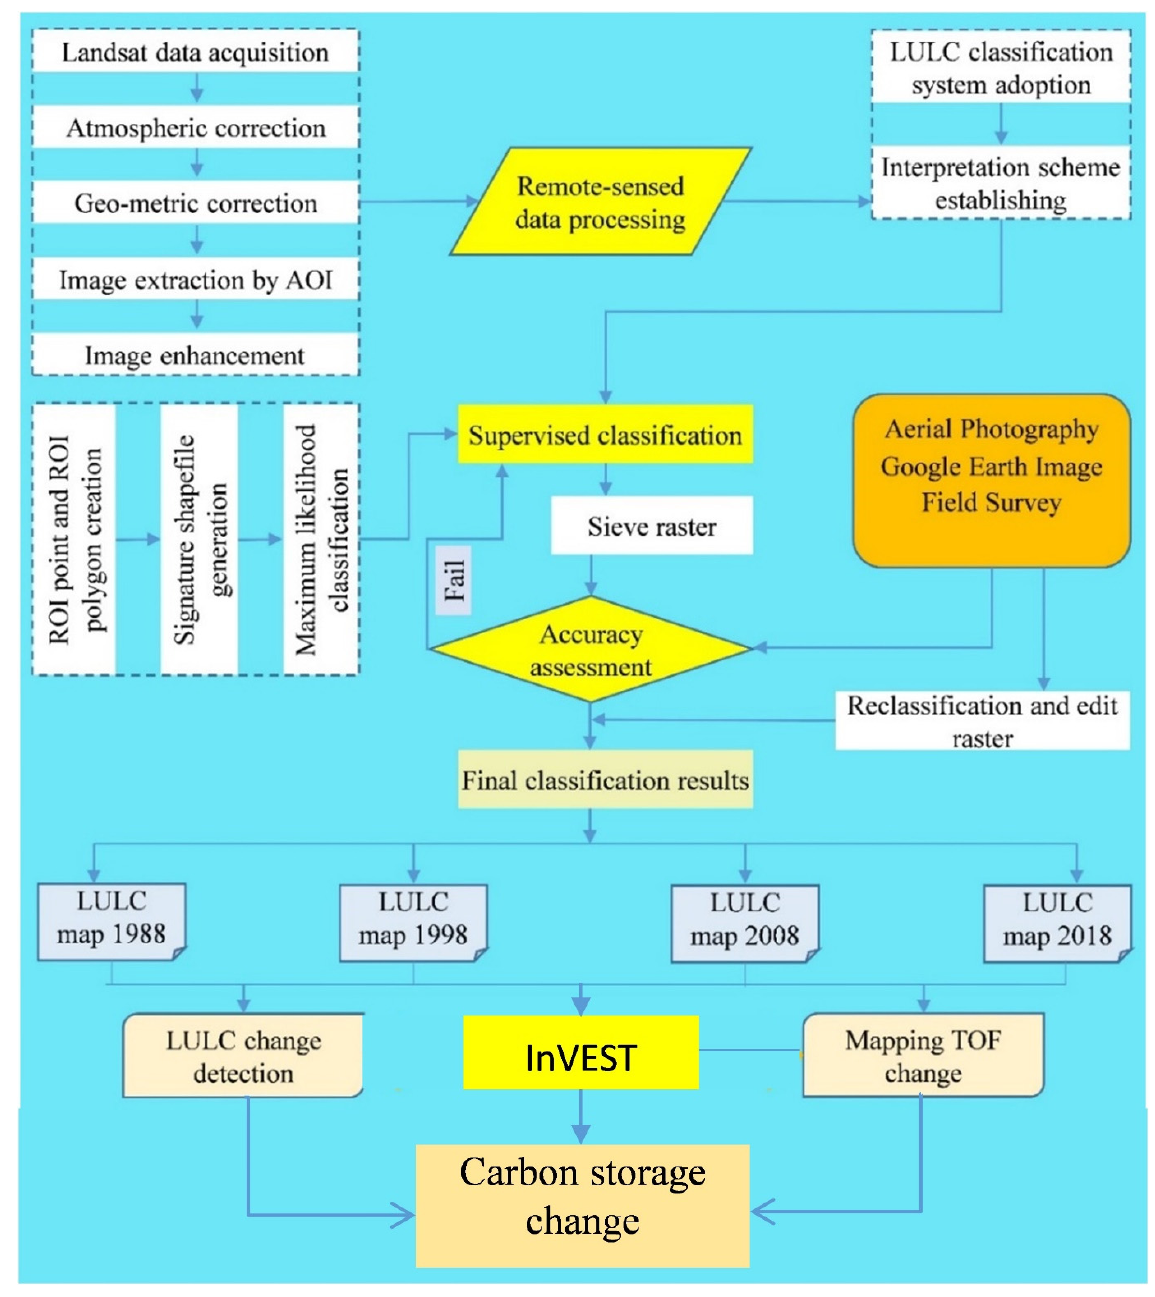
Figure 2. Framework of the study.